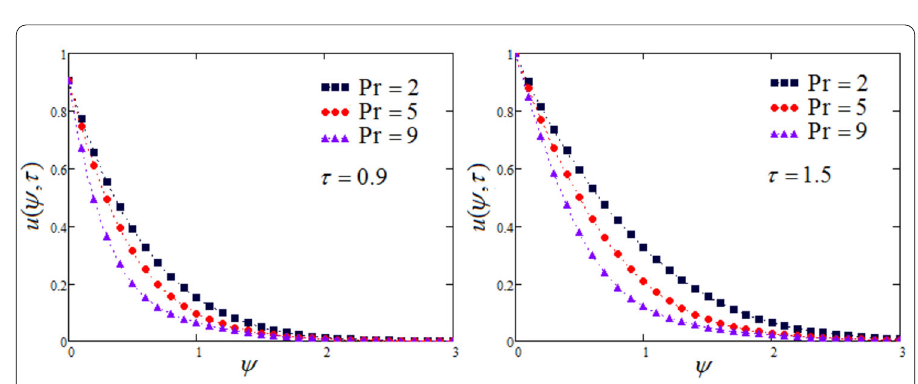
Figure 8 Velocity profiles of a Maxwell fluid for various values of Pr at two different times